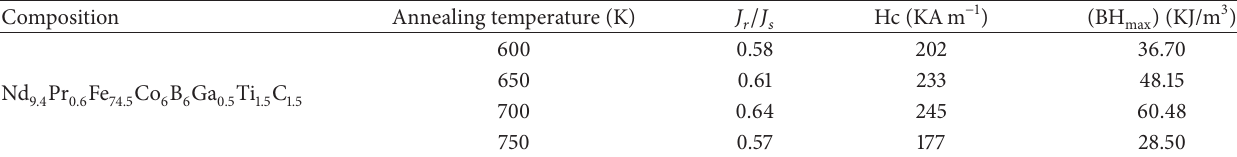
Table 1: Magnetic properties of annealed ribbon at different annealing temperature for 10